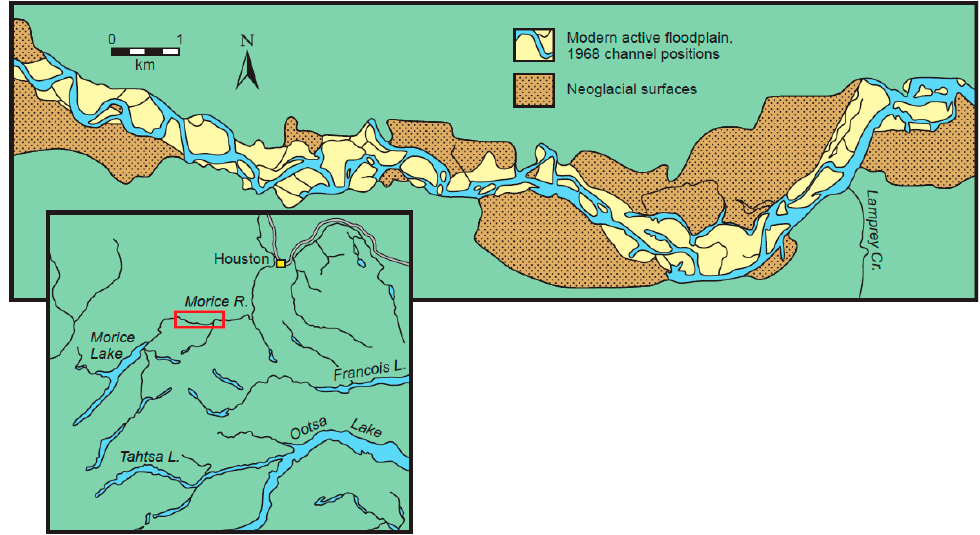
Figure 10. Modern (1990) and Neoglacial floodplains of a section of Morice River, central Coast Mountains, British Columbia. The Neoglacial (19th century) floodplain was twice as wide as the floodplain today. Modified from [101].